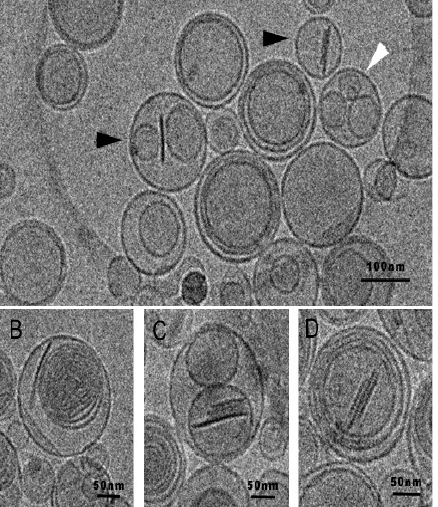
Figure 18. Cryo-TEM images of a sample containing bicosomes. ( A ) High variability of vesicles is observed: empty vesicles (black arrows); oligolamellar structures (white arrowheads) and multilamellar vesicles (white arrows); vesicles with bicelles inside (black arrowheads). ( B ) Multilamellar vesicles. ( C ) Stacked bicelles inside vesicles. ( D ) Stacked bicelles inside multilamellar